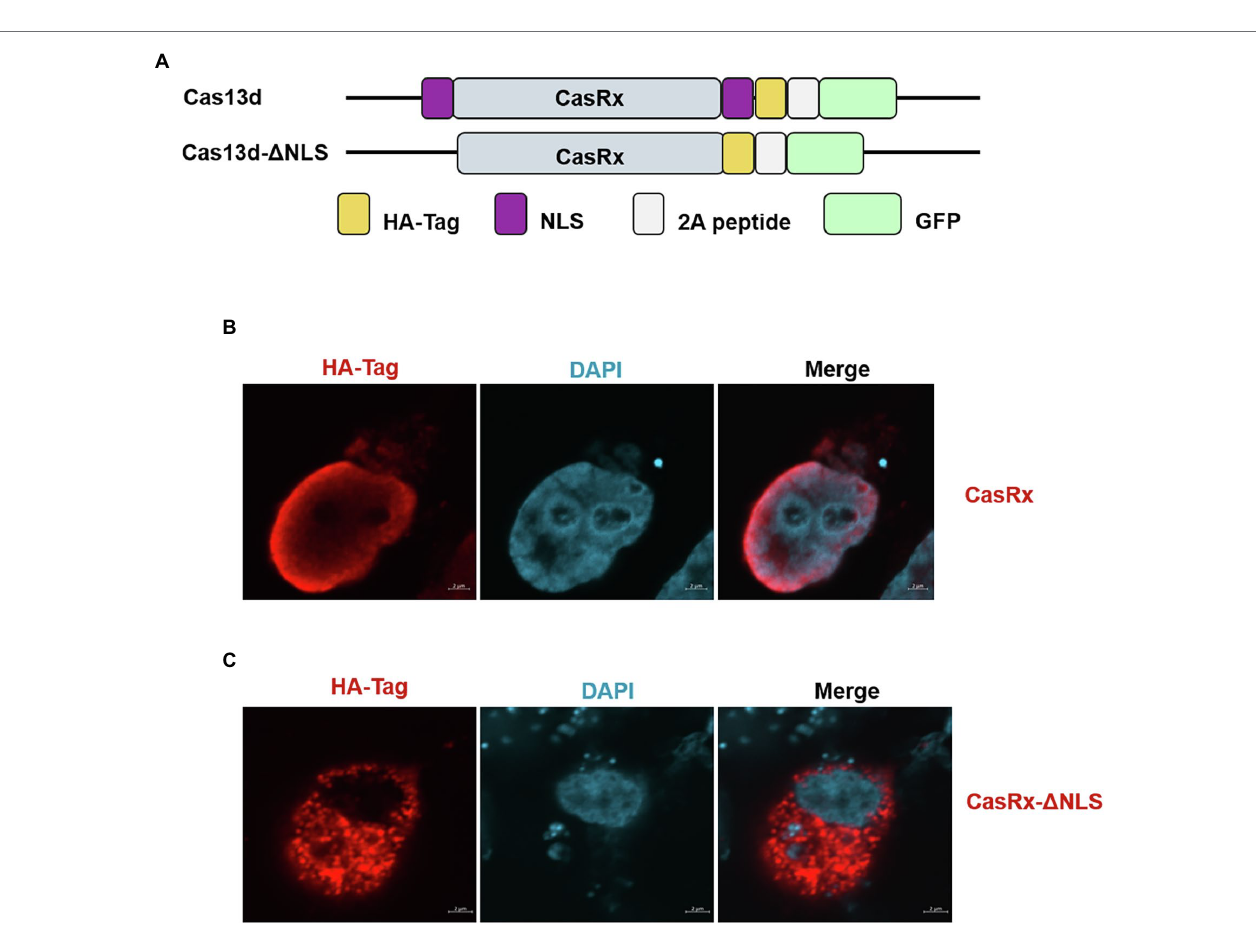
FIGURE 2 | Deletion of the nuclear localization signal (NLS) regulates Cas13d subcellular localization. (A) Summary of the constructs used in this study. Cas13d contains two NLSs that allow Cas13d to enter the nucleus. Removal of the NLS enables Cas13d to cleave the complementary target RNA within the cytoplasm but not the nucleus. (B) HEK293T cells were transfected with the CasRx expression vector or (C) CasRx-del-NLS, and then, IFA was performed at 24 hpi; the HA tag at the C-terminus of Cas13d was stained and labeled with Alexa Fluor 568-conjugated goat antibodies. Nuclei were labeled with DAPI. Scale bar = 2 μ